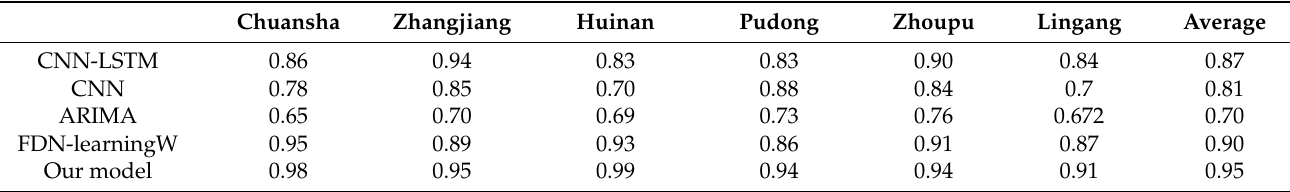
Table 4. Performance comparison of different models on R 2 .